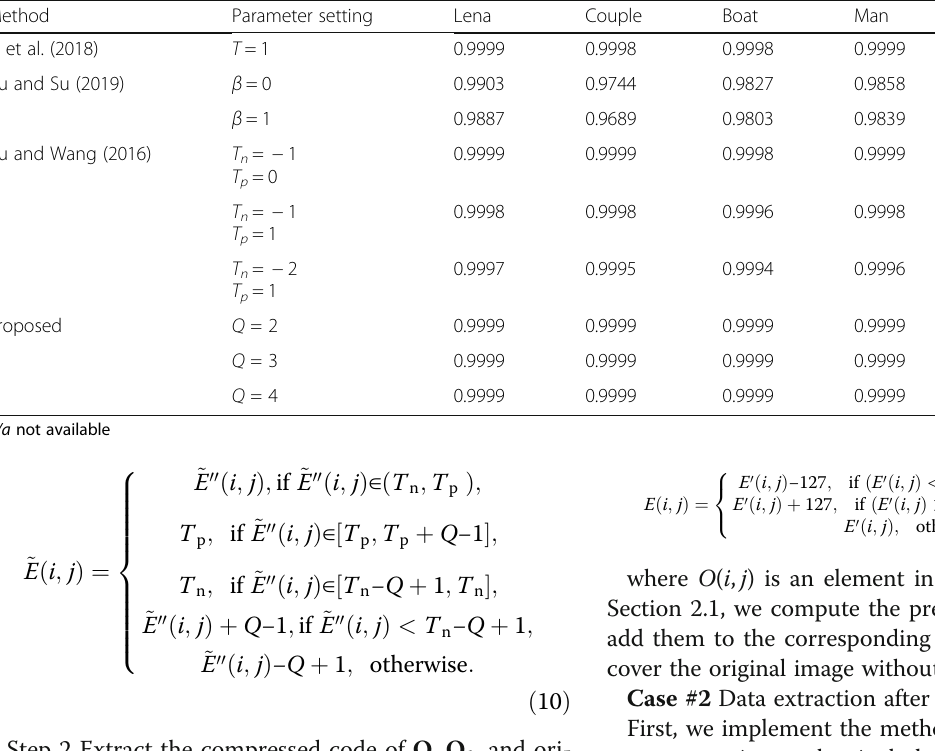
Table 4 Comparisons among four methods in terms of SSIM Method Parameter setting Lena